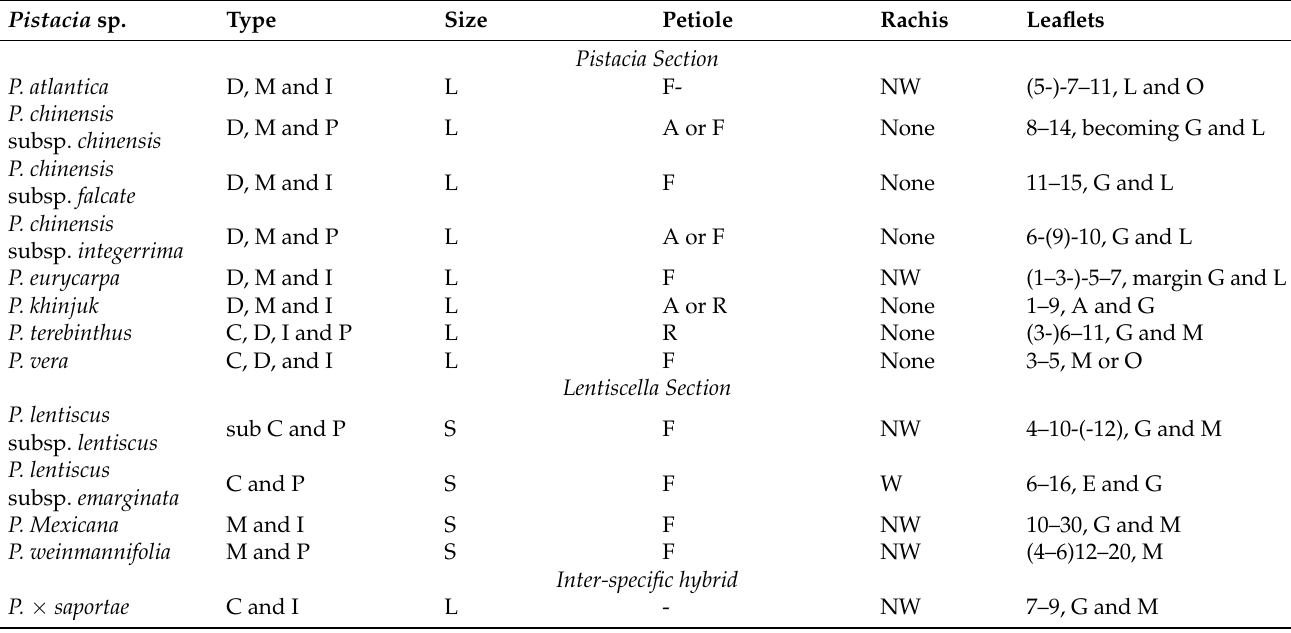
Table 1. Morphological identification and division of main Pistacia species based on leaves character- istics in three sections (modified from Al-Saghir and co-workers